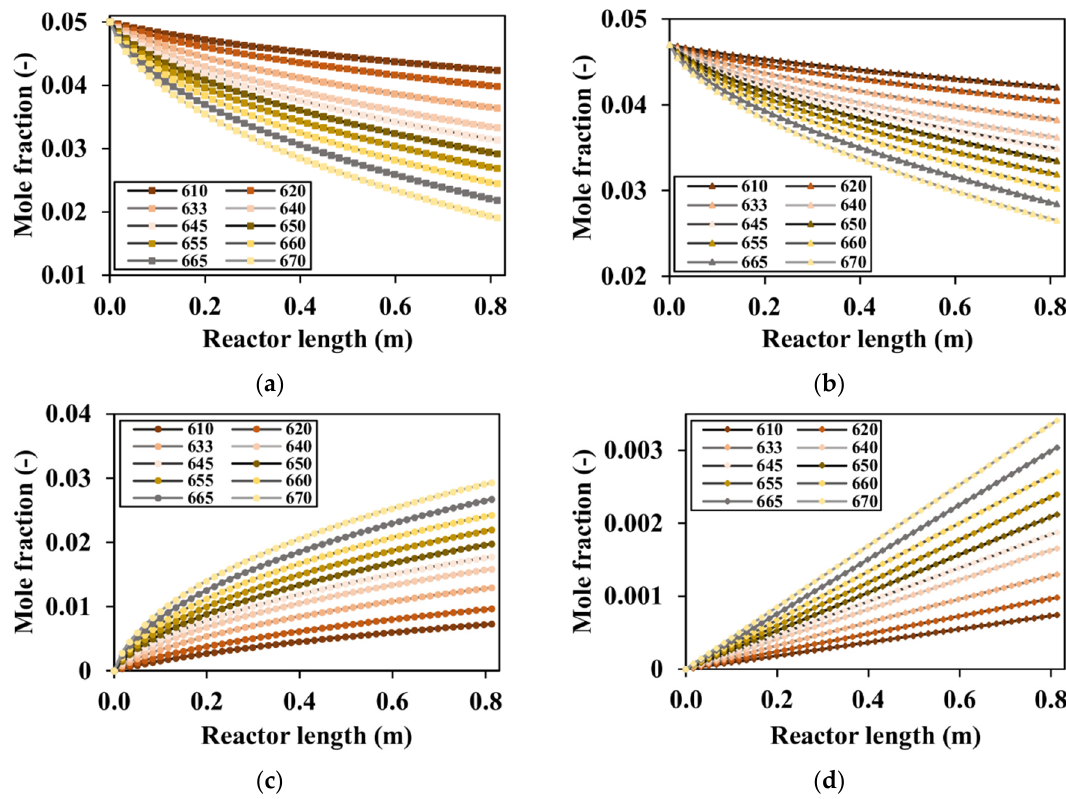
Figure 11. Mole fraction distribution along the reactor length at the temperature range between 610 K and 670 K: ( a ) butene; ( b ) oxygen; ( c ) butadiene; ( d ) carbon dioxide.